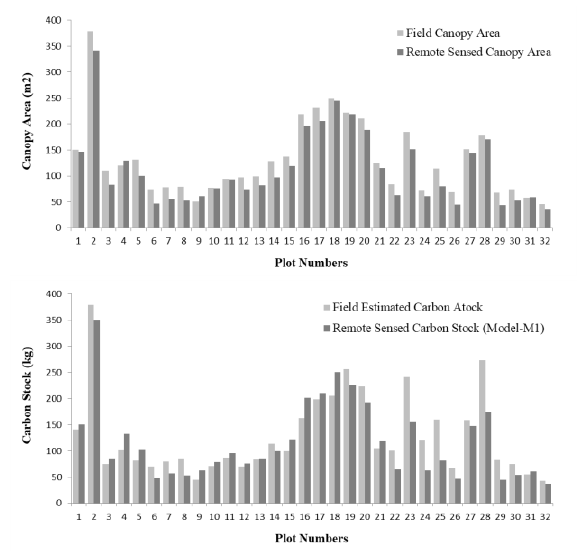
Figure 8. Field estimated carbon stock and remote sensed carbon stock (Model-M1) for each plot size is 30x30m. For detailed values see Tables 4 and 5.